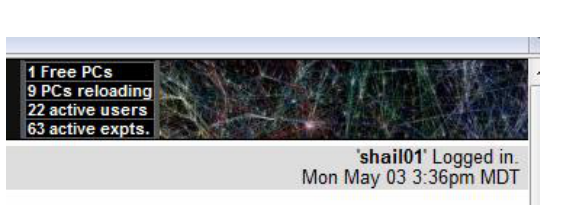
Fig. 8: Outage of ProtoGENI Resources through many sliver by single user